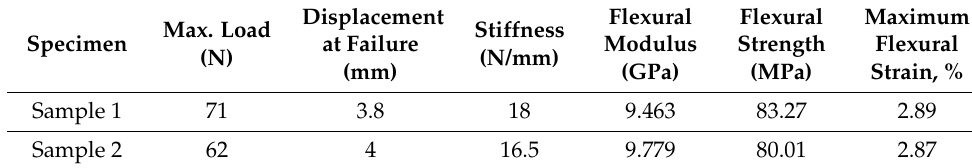
Figure 7. Flexural testing plots of test specimens: ( a ) Sample 1, ( b ) Sample 2 . Table 4. Flexural modulus, flexural strength, and Elongation.